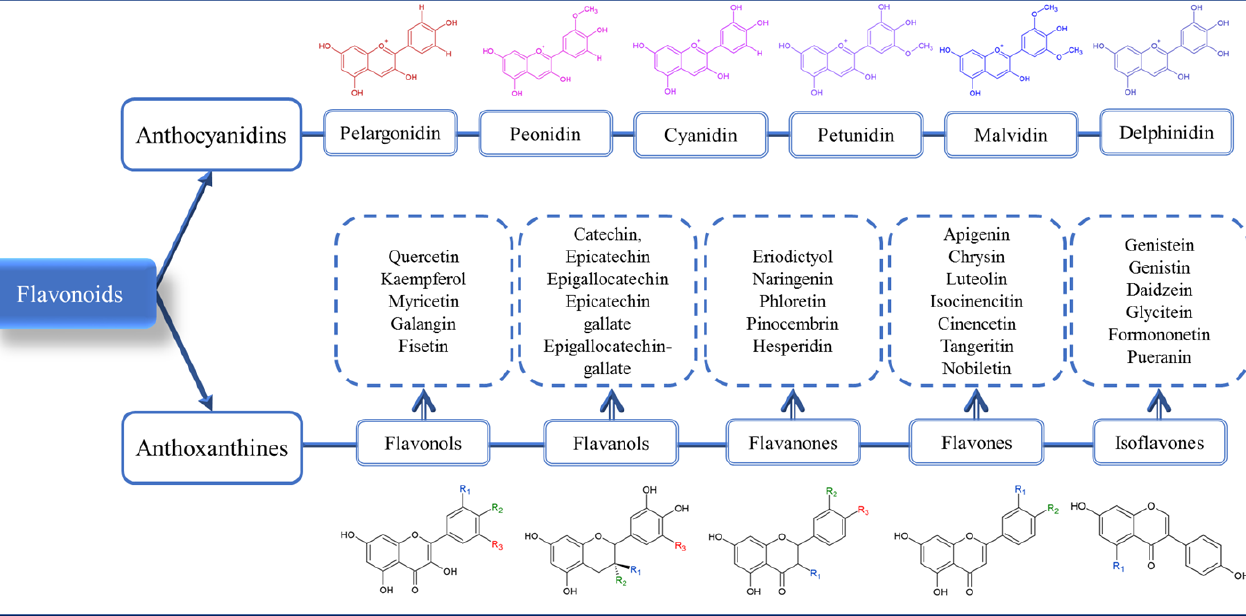
Figure 2. Chemical structure of main flavonoids found in cereals and pseudocereals. Phenolic acids include hydroxybenzoic (gallic, protocatechuic, vanillic, syringic) and hydroxycinnamic (coumaric, caffeic, sinapic, ferulic) acids. In addition to hydroxybenzoic and hydroxycinnamic acids, hydroxyphenylacetic and hydroxyphenylpropanoic acids can be found in pseudocereals [19,20]. On the other hand, flavonoids comprise many compounds, especially anthoxanthines (flavonols, flavones, flavanols, flavanones and isoflavonoids), anthocyanidins, and anthocyanins. Some examples of flavonoids are (i) an- thocyanidins (cyanidin, petunidin, pelargonidin, delphinidin, peonidin, malvidin) or an- thocyanins when glycosylated on C3, forming C3- O -glucoside; (ii) flavonols (quercetin, kaempferol, myricetin, galangin, and fisetin); (iii) flavones (apigenin, chrysin, luteolin, isocinencitin, cinencetin, tangeritin, and nobiletin); (iv) flavanols (catechin, epicatechin,